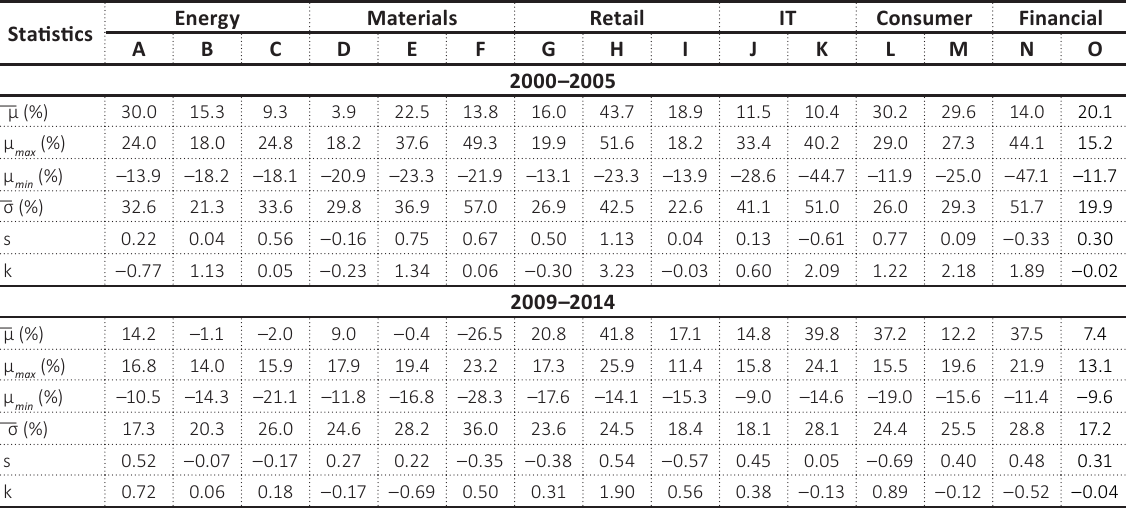
Source: Bloomberg and authors’